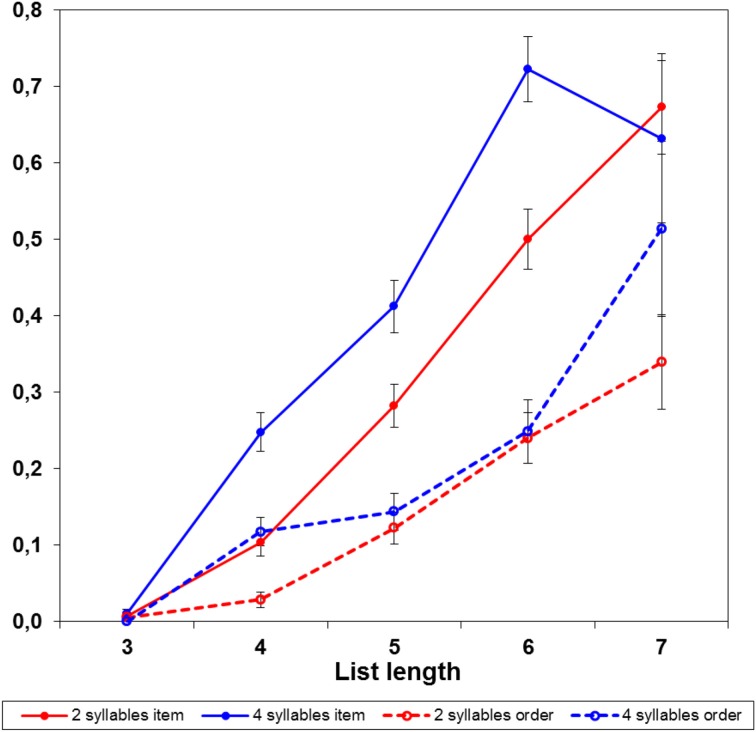
Probability of item and ordering errors by word length and list length, controlling for the number of lists presented at each length. Bars indicate the standard error of probabilities.